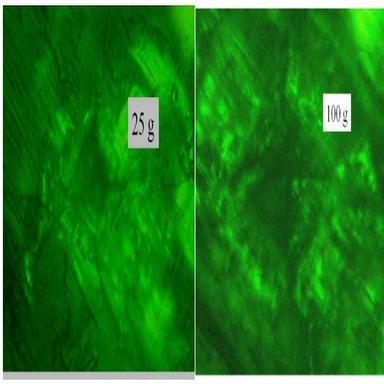
The indentation impressions obtained for different loads images of PCOH.